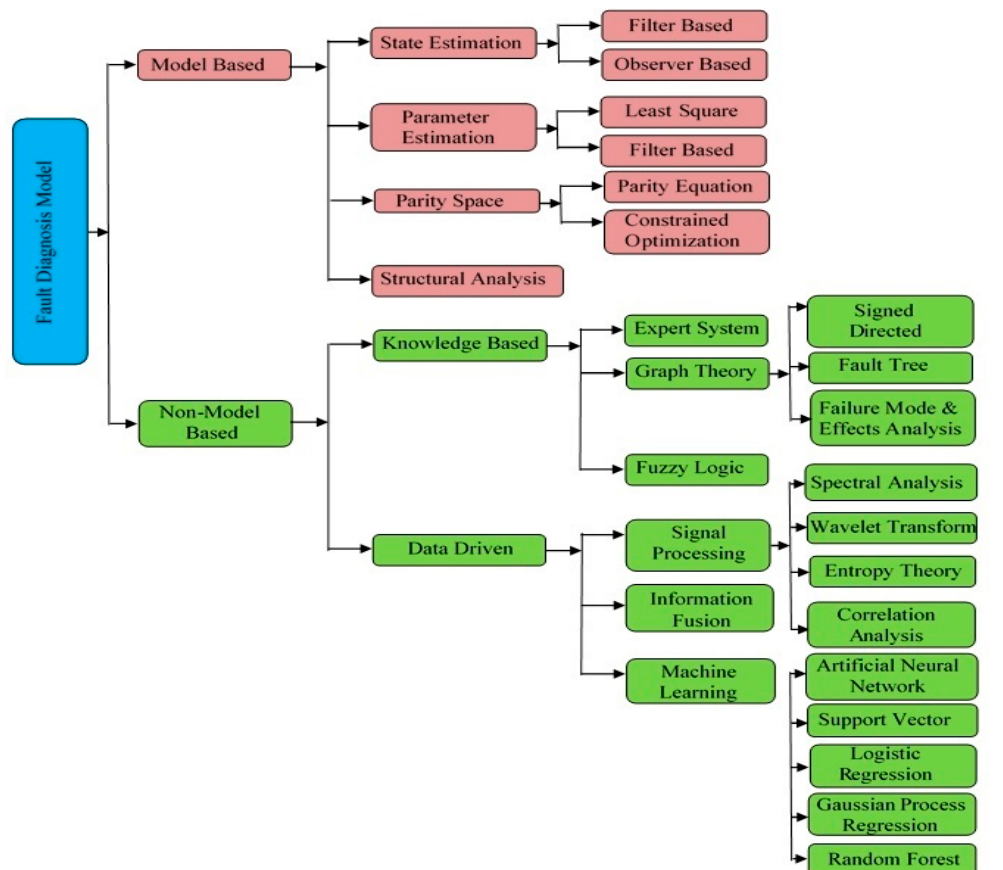
Figure 1. Classification of LIB fault diagnosis methods.